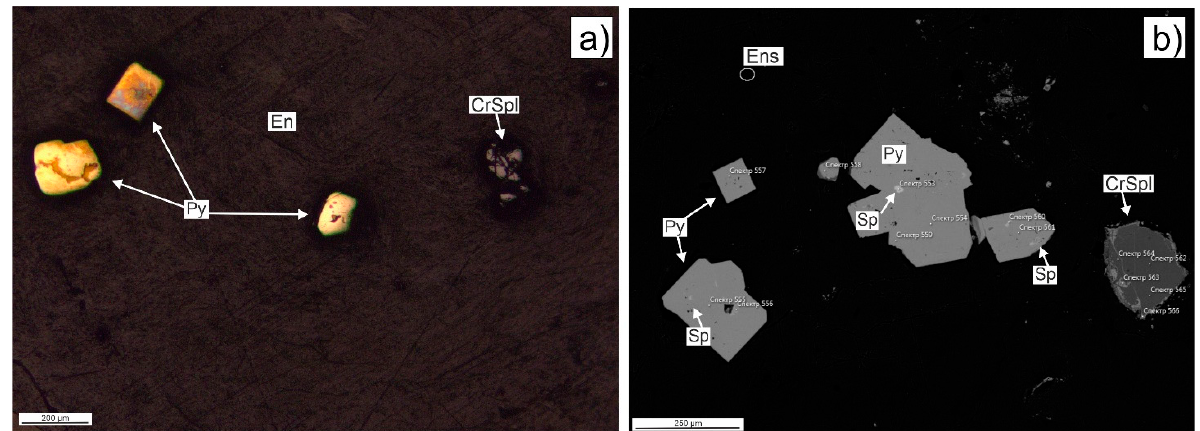
Figure 11. Vein ‐ disseminated mineralization. ( a ) Pyrite grains and Cr ‐ spinels in hydrothermally al ‐ Figure 11. Vein-disseminated mineralization. ( a ) Pyrite grains and Cr-spinels in hydrothermally tered enstatite. ( b ) Pyrite grains and Cr ‐ spinels in hydrothermally altered enstatite. BSE image. altered enstatite. ( b ) Pyrite grains and Cr-spinels in hydrothermally altered enstatite. BSE Table 4. Average chemical composition of minerals from vein ‐ disseminated samples.